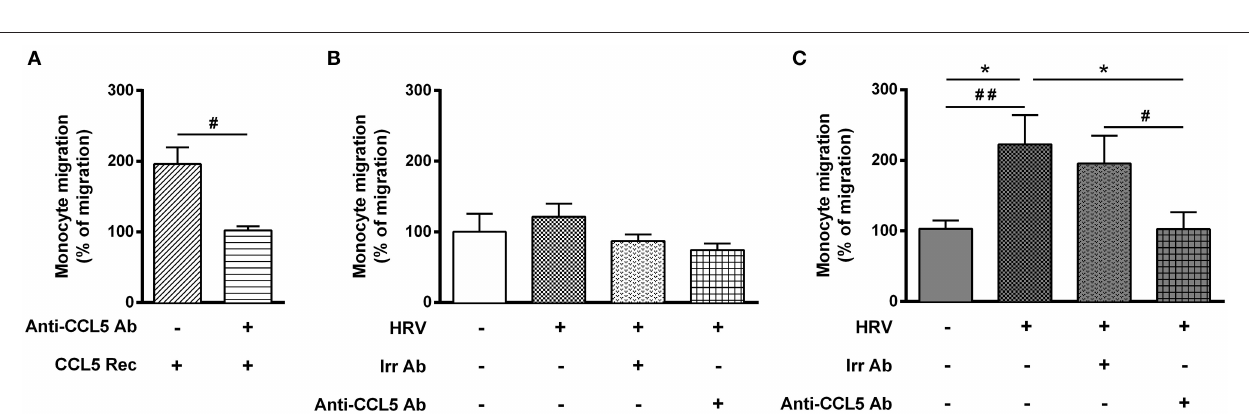
FIGURE 3 | Asthmatic bronchial smooth muscle cell co-culture increases CCL5 expression in epithelial cells after rhinovirus infection. (A) CCL2, (B) CCL5, (C) CCL17, (D) CXCL1, (E) CXCL2, (F) CXCL5, (G) CXCL6, (H) CXCL9 proteins were quantified in co-culture supernatants by multiplex ELISA. Data are presented as mean ± SEM values ( n = 8–11 per group, one-way ANOVA, Newman-Keuls multiple comparisons test, * P < 0.05; ** P < 0.01).